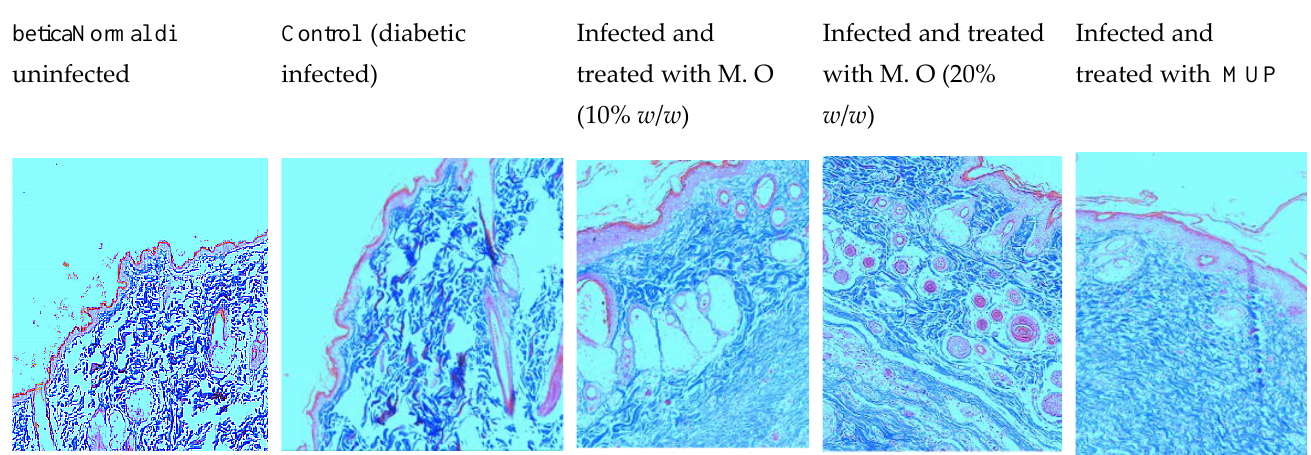
Figure 5. Histology of skin from diabetic animals infected with MRSA stained with H & E stain (100×) . Photomicrographs showing regenerated epithelium in different groups. Black arrows show epidermis, yellow arrow shows capillaries, and red arrow shows inflammatory cells. In normal animals, the height of the epidermis is high, with a number of capillaries and few inflammatory cells. In infected animals, the epidermal height was noticeably less, with fewer capillaries and more inflammatory cells. The epithelial height, capillaries and the number of inflammatory cells were more in the M. oleifera - and mupirocin-treated animals. M.O = M. oleifera leaf extract formulation, MUP = mupirocin (2% w / w ).